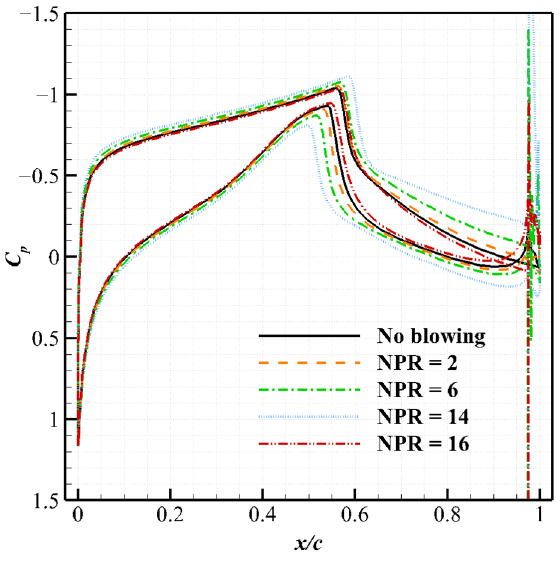
Figure 22. Comparison of pressure coefficients due to changes in NPR ( Ma =